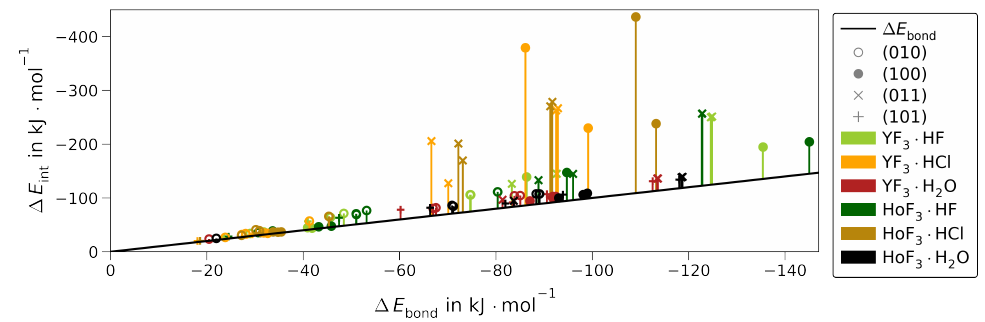
Figure 5. Interaction energy ( ∆ E int ) vs. bonding energy ( ∆ E bond ) for all non-hydride-forming MF 3 · Ads for each surface (marker) of YF 3 (light green/orange/red) or HoF 3 (dark green/brown/ black) without the 7 Å-wide dissociated (100) · HCl. The difference ( ∆ E prep , see Equation (3)) is emphasized by